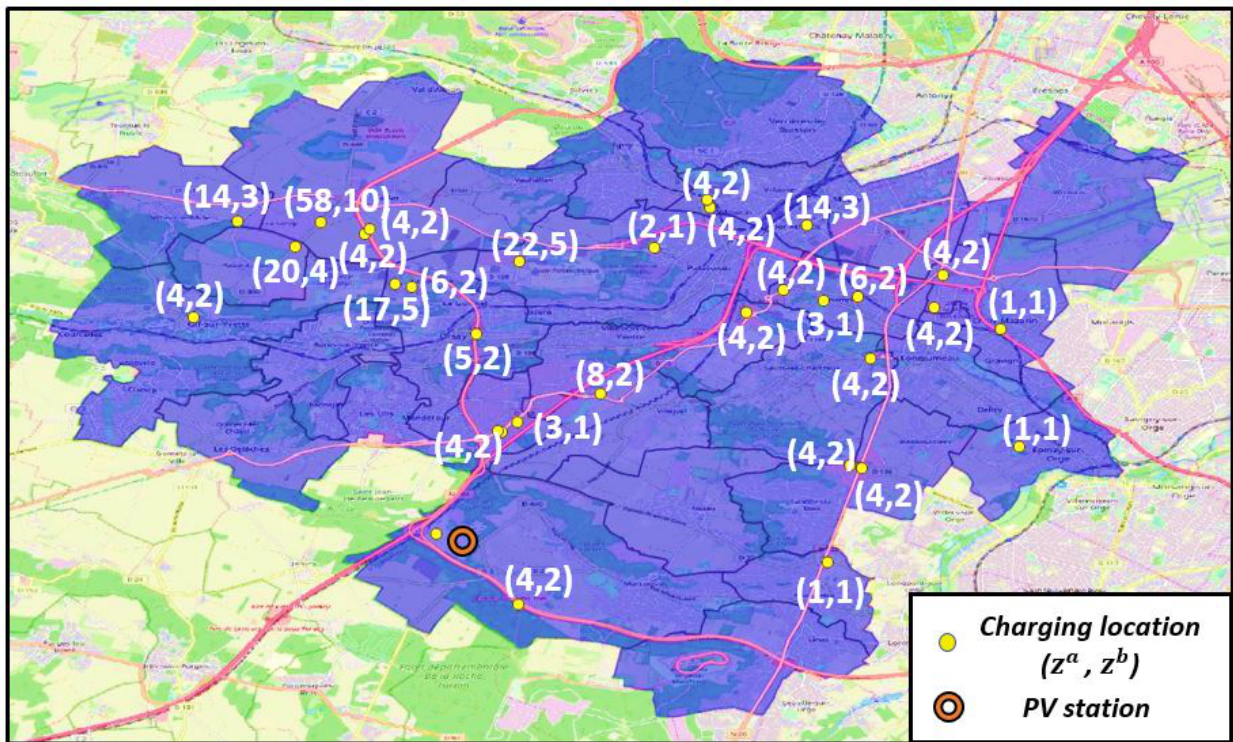
Figure 7. Number of chargers per